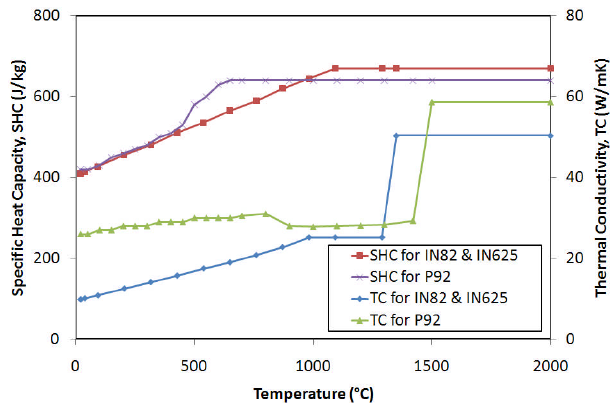
Figure 6. Complete 2D axisymmetric FE mesh.